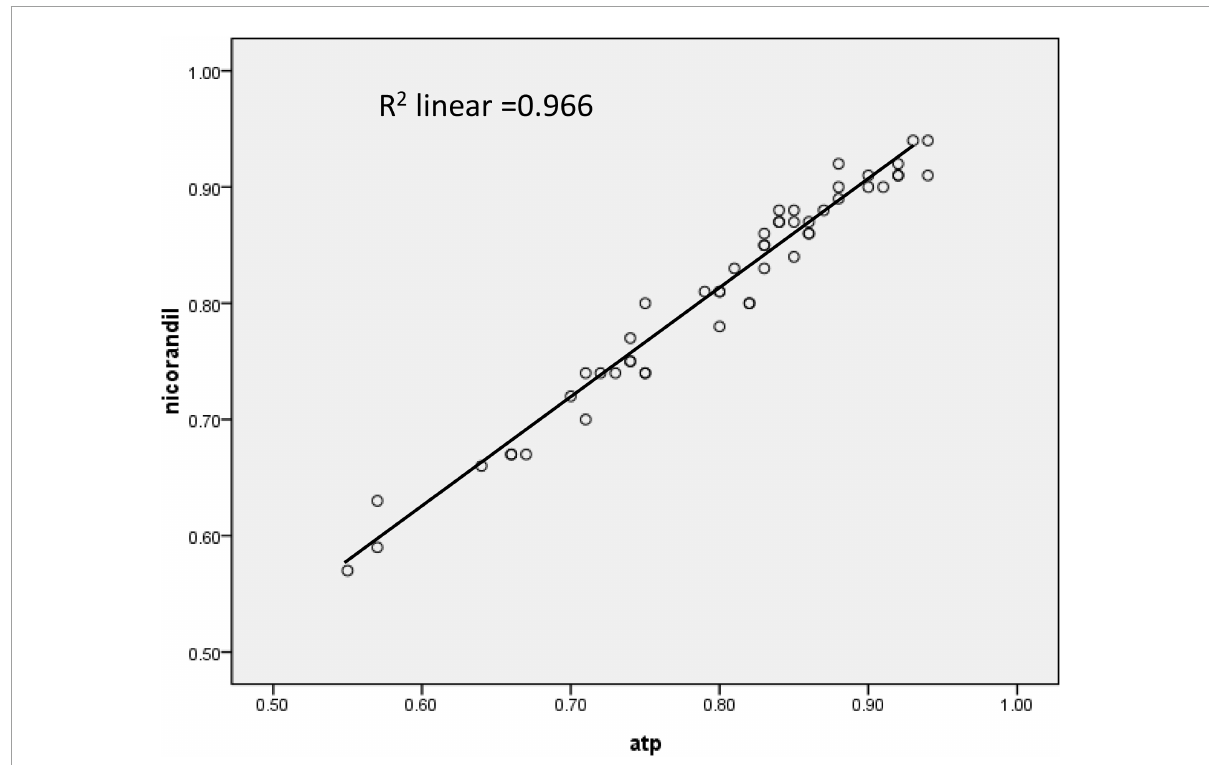
FIGURE1 The correlation of fractional flow reserve (FFR) between an intracoronary nicorandil bolus (2 mg) and an intravenous infusion of adenosine 5 (cid:48) -triphosphate (ATP) (167